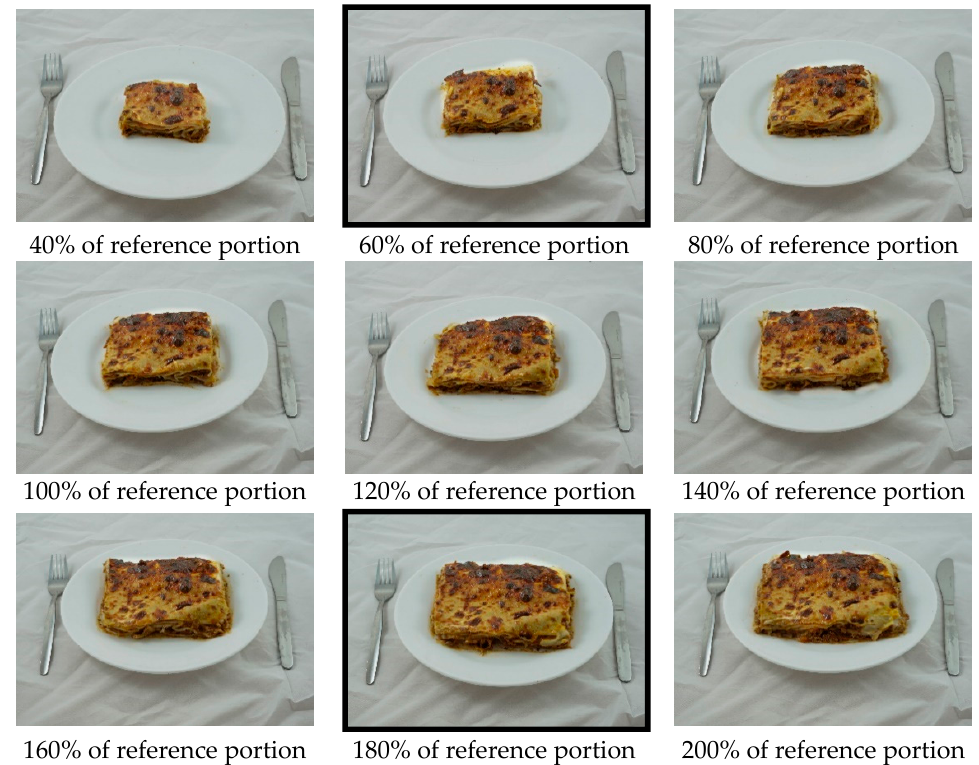
Figure 1. Portion size scale for lasagna ranging from 40% to 200% of the manufacturer’s recommended serving with a 20% difference between portions. The highlighted portions were used as the smaller and larger portion sizes in the first session of Study 1.